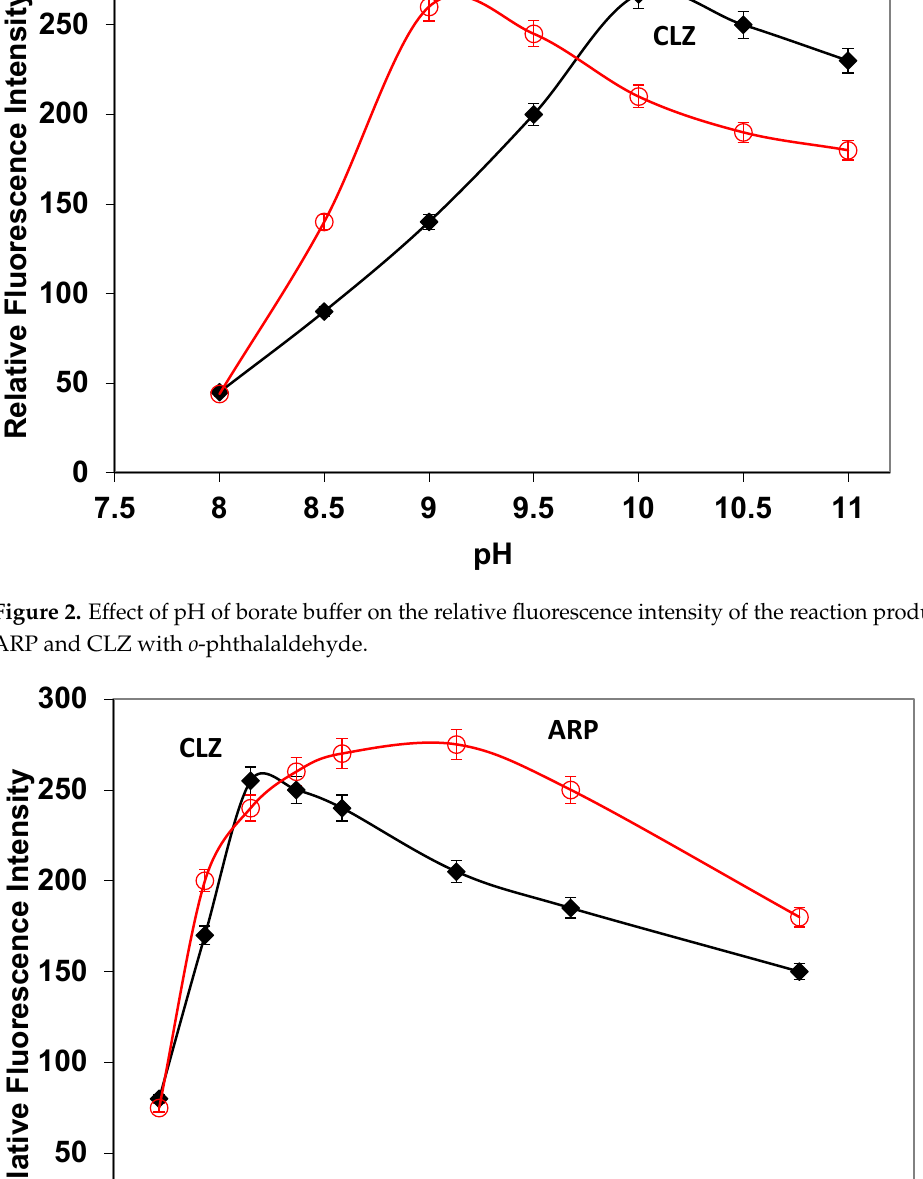
Figure 4. Effect of volume of β -mercaptoethanol (1.0% v/v ) on the fluorescence intensity of the reac- tion product of ARP and CLZ with o -phthalaldehyde in borate buffer.